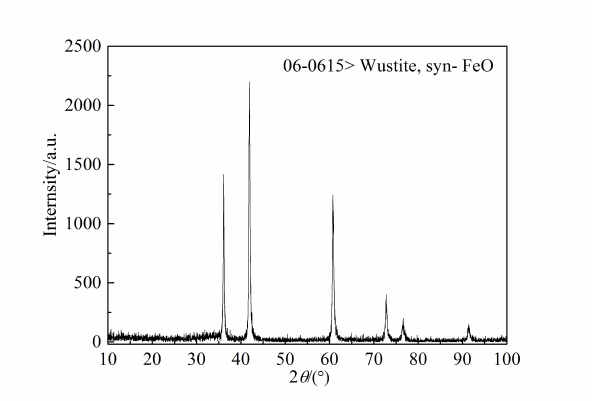
Figure 1: XRD pattern of thermal decomposition product for FeC 2 O 4 · 2H 2 O in argon at 850 ∘